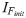
Steady-state sensitivity analysis for inhibitor doses.Note that inhibitor treatments are plotted as multiples of the standard dose (6.12×107 inhib. cm−3). In Cases A and B the number of bound bacteria, BB, is a monotone decreasing function of the inhibitor dose, IFinit, while the number of free bacteria, BF, increases initially, before decreasing with increasing inhibitor dose. The total number of bacteria, BT, is a monotone decreasing function of the inhibitor dose in Case A, while it increases initially, before decreasing with increasing inhibitor dose, in Case B. In Case C both free and bound bacterial numbers, and hence the total number of bacteria, are increasing functions of the inhibitor dose within the range IFinit∈[0,6.12×107] inhib. cm−3, while in Case D inhibitors have little effect on the steady-state bacterial numbers within this range. The insets in the lower panels show the steady-state behaviour for higher inhibitor doses. Eqs 1–11 were solved using ode15s, allowing the system to evolve until it reached steady-state and neglecting the Heaviside step functions which prevent the logistic growth of bacteria when their population size goes beneath one. Parameter values: ψ˜Bac=0 hr−1, ψ˜I=0 hr−1, λ = 0 cm3cell−1hr−1, ρ = 0 hr−1, ω = 1 and A = 0 μg cm−3. See Tables 2–4 for the remaining parameter values.